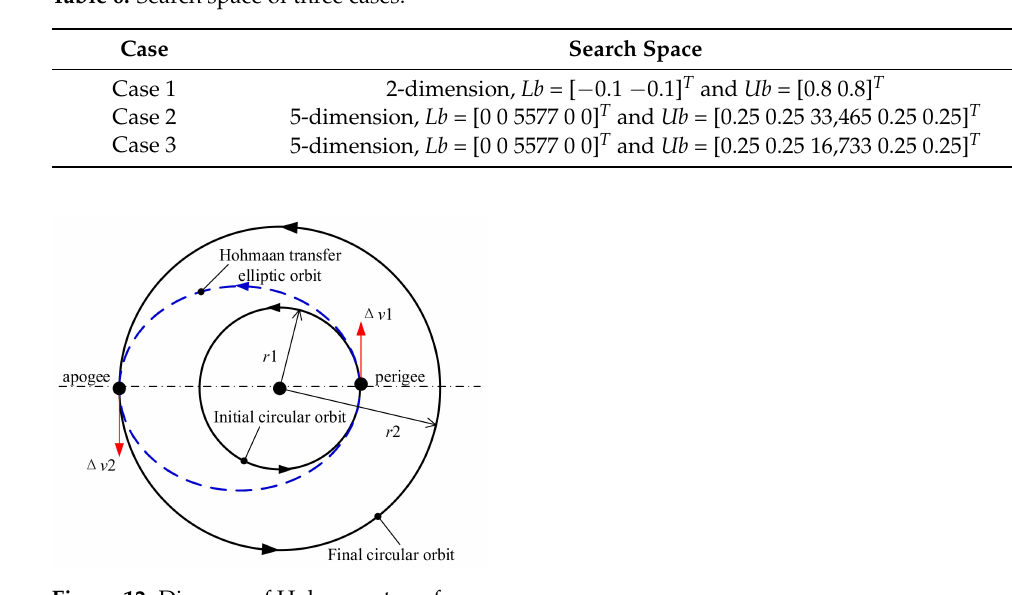
Figure 12. Diagram of Hohmann